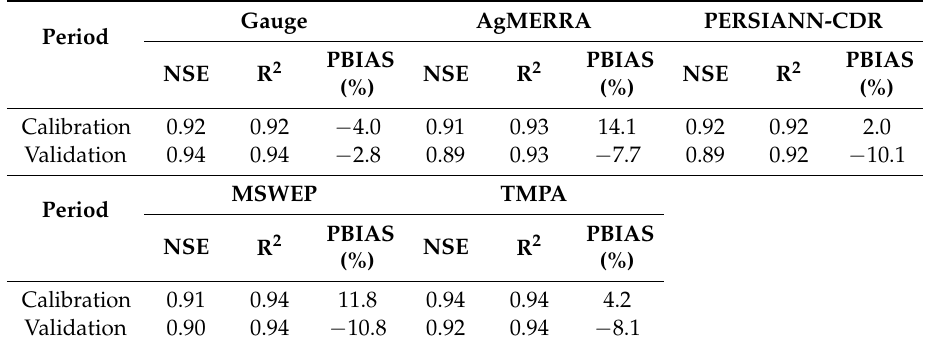
Table 5. Indexes for the performance of SWAT model both in calibration and validation